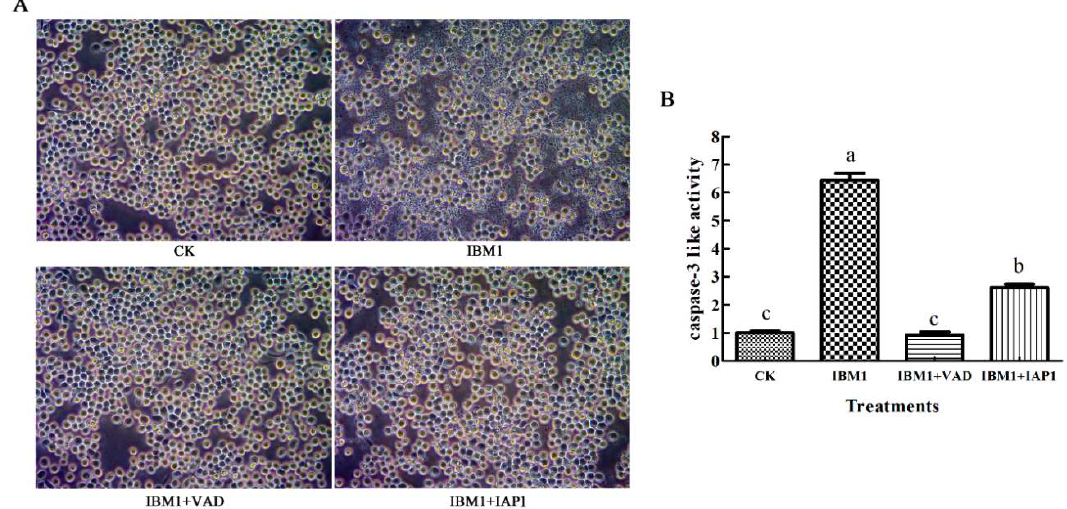
Figure 6. Apoptosis induced by the overexpression of Sf-IBM1 was inhibited by both carbobenzoxy- valyl-alanyl-aspartyl-[ O -methyl]-fluoromethylketone (Z-VAD-FMK) and Sf-IAP1. ( A ) Morphological changes of cells treated with different agents by inverted phase contrast microscopy ( 20×) . ( B )